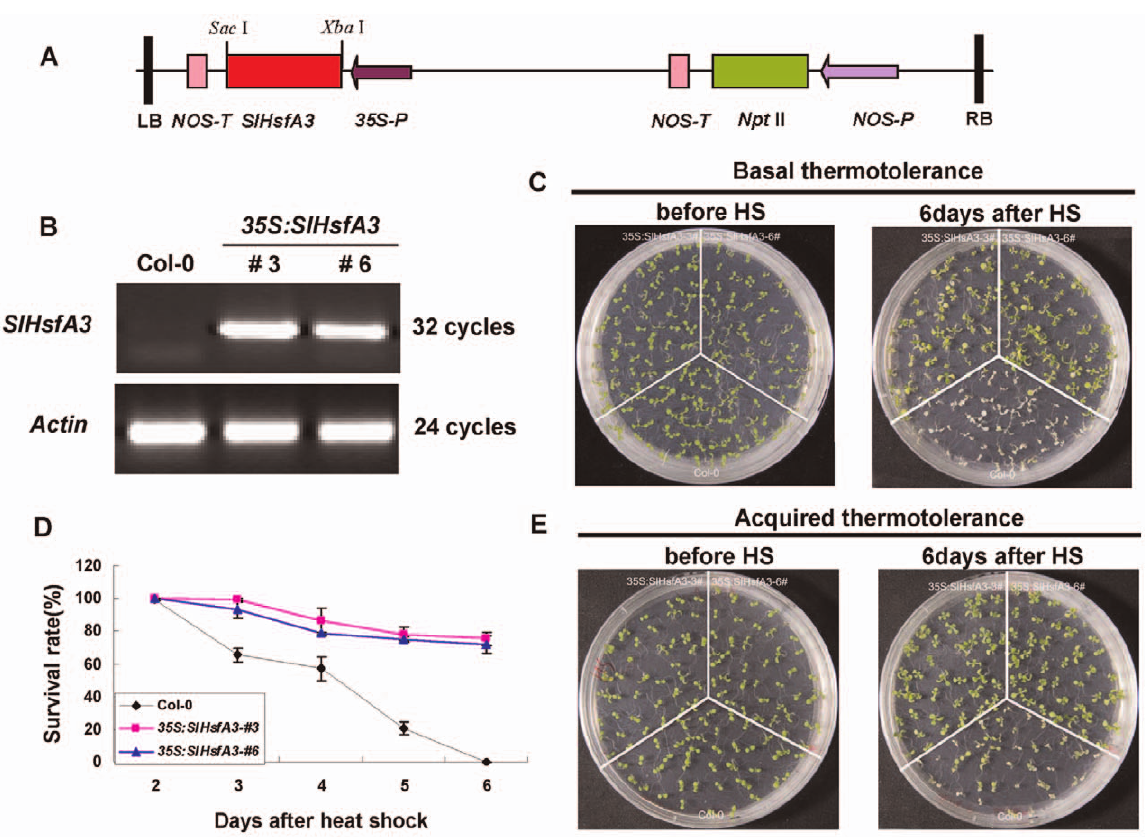
Figure 5. Thermotolerance of Col-0 and 35S:SlHsfA3 transgenic Arabidopsis plants. (A) Schematic representation of a construct used for Arabidopsis transformation of the SlHsfA3 gene. (B) Relative expression of SlHsfA3 in Col-0 and two T 3 generation transgenic lines. Total RNA was extracted from 10-d-old seedlings, then analyzed by semi-quantitative RT-PCR. The ACTIN7 gene was used as an internal control. (C) Comparison of basal thermotolerance among Col-0 and two OE lines. (D) Survival rates of Col-0 and two OE lines after HS at 43 u C for 1 h. Seedlings that showed obvious etiolation appearance were considered to be dead. For each experiment, about 50 plants were used; values are means 6 SD from three independent measurements. (E) Comparison of acquired thermotolerance among Col-0 and two OE